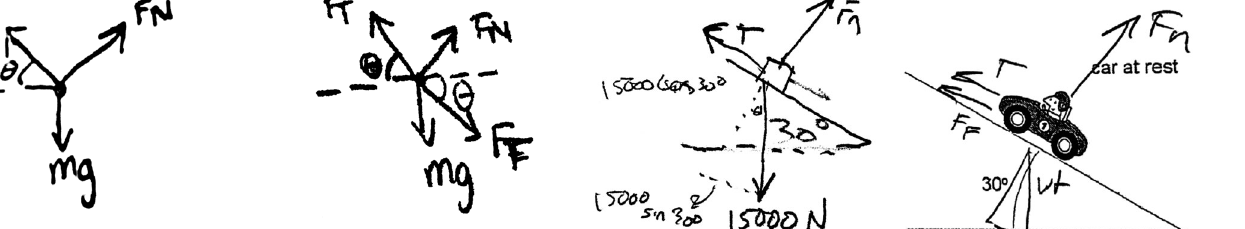
FIG. 5. An example of the different FBDs drawn for the tension problem (left) and the friction problem (right) by the same student. This student mistakenly included an additional tension force in the FBD for the friction